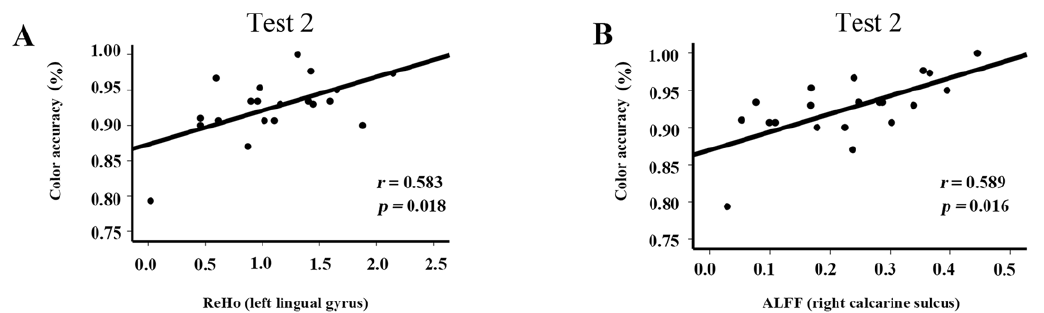
Figure 5. Correlations between spontaneous brain activity and behavior results in Test 2: ( A ) Correlation between color accuracy in the visual task and ReHo in the left lingual gyrus; ( B ) correlation between color accuracy in the visual task and ALFF in the right calcarine gyrus.